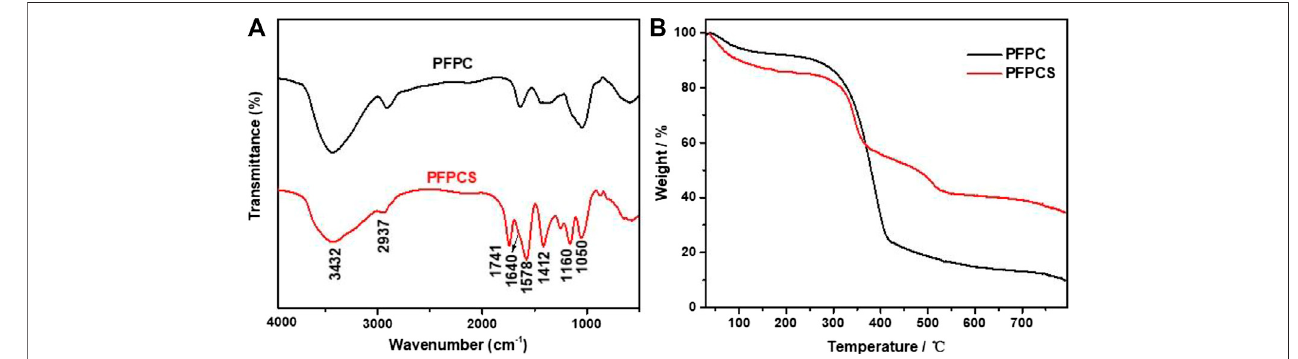
FIGURE 2 | The SEM images of PFPC (A) and PFPCS (B) , respectively. (C) The XRD pattern of PFPC and PFPCS. (D) The Zeta potential curves of PFPC and PFPCS.